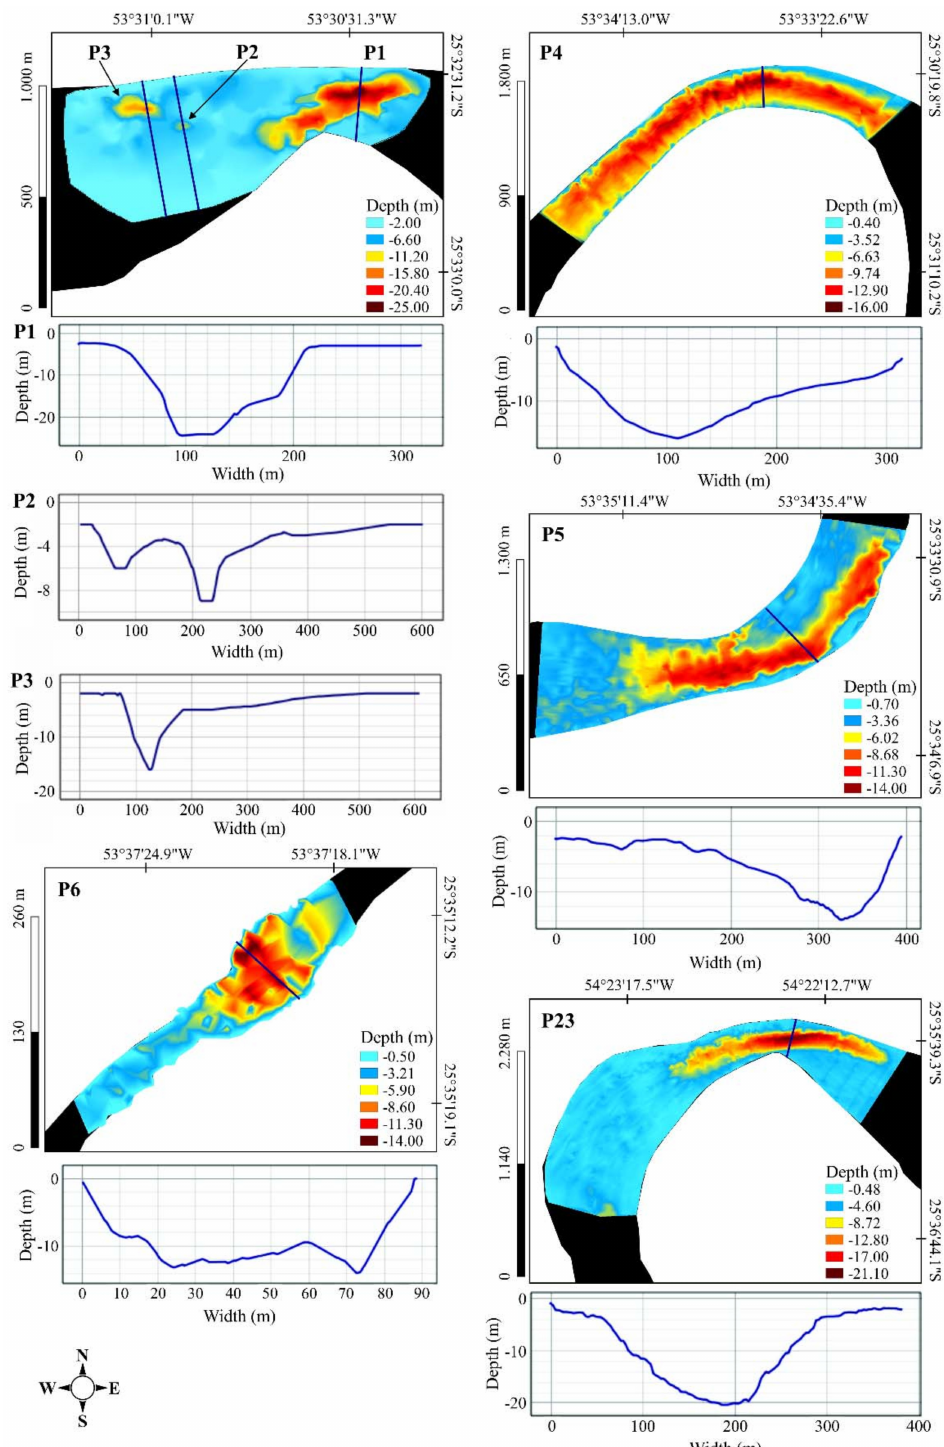
Figure 6. Map and bathymetric profile of the margin-to-margin deep pools’ transverse transects in the main channel of the Iguaçu River outside of the INP (P1, P2, P3, P4, P5) and inside of the INP (P23), and a tributary, namely, Capanema River (P6), outside of the INP. The bathymetric profile of the cross-section (blue line) corresponds to the portion with the greatest